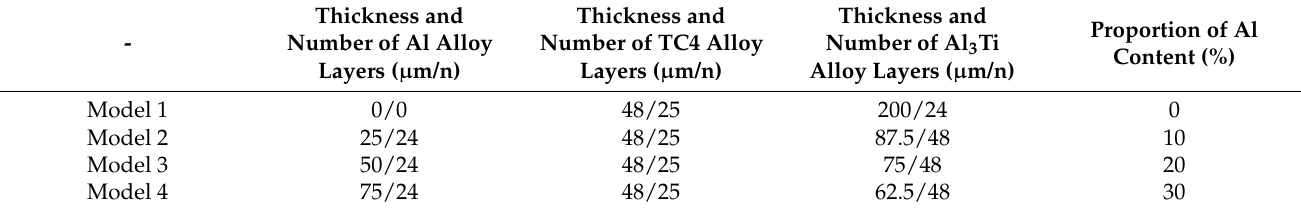
Table 2. Size parameters of the target model containing different percentages of Al.